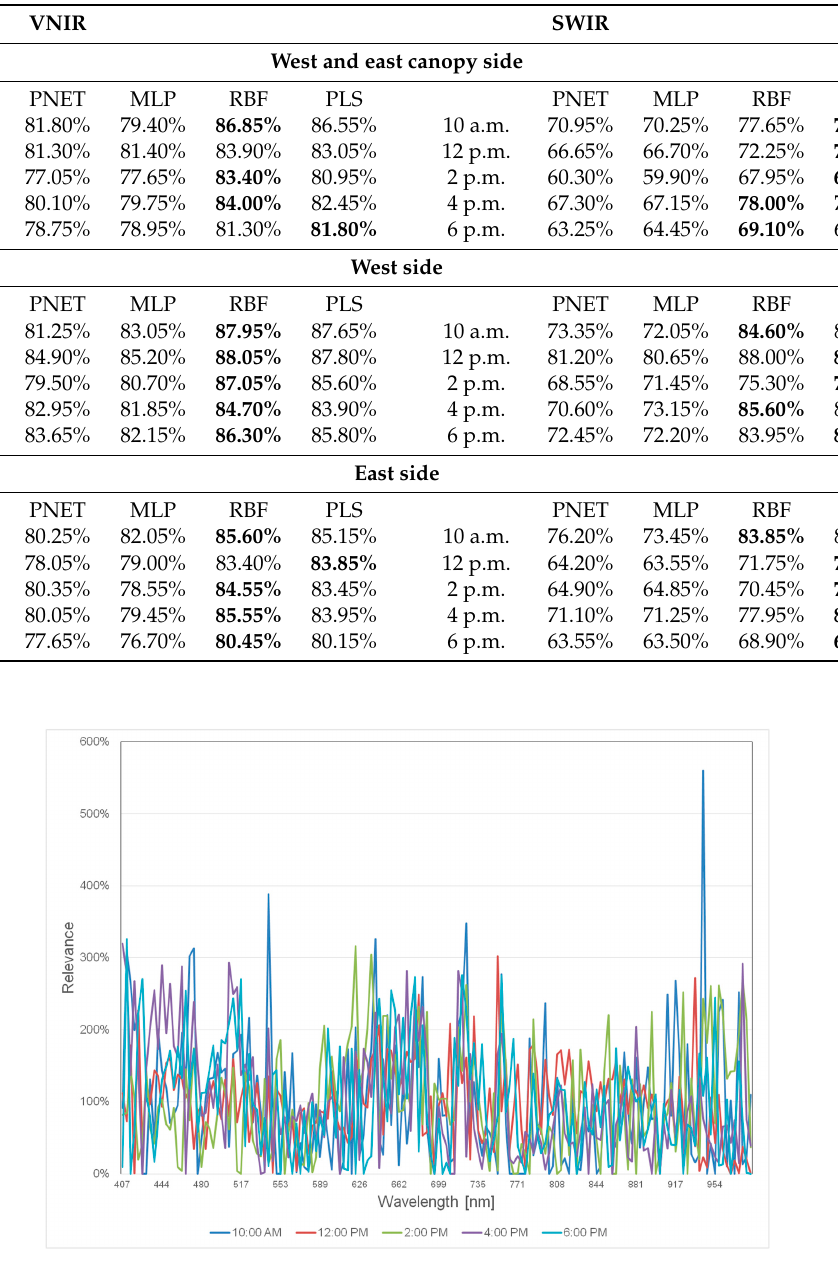
Figure 10. Relevance profile of the visual-near infrared range based on RBF performance at different recording times.